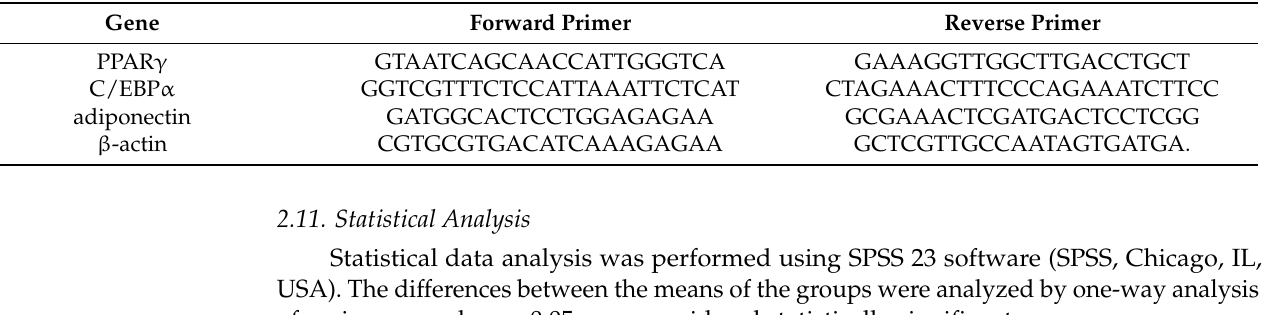
Table 1. Primer sequences used for quantitative